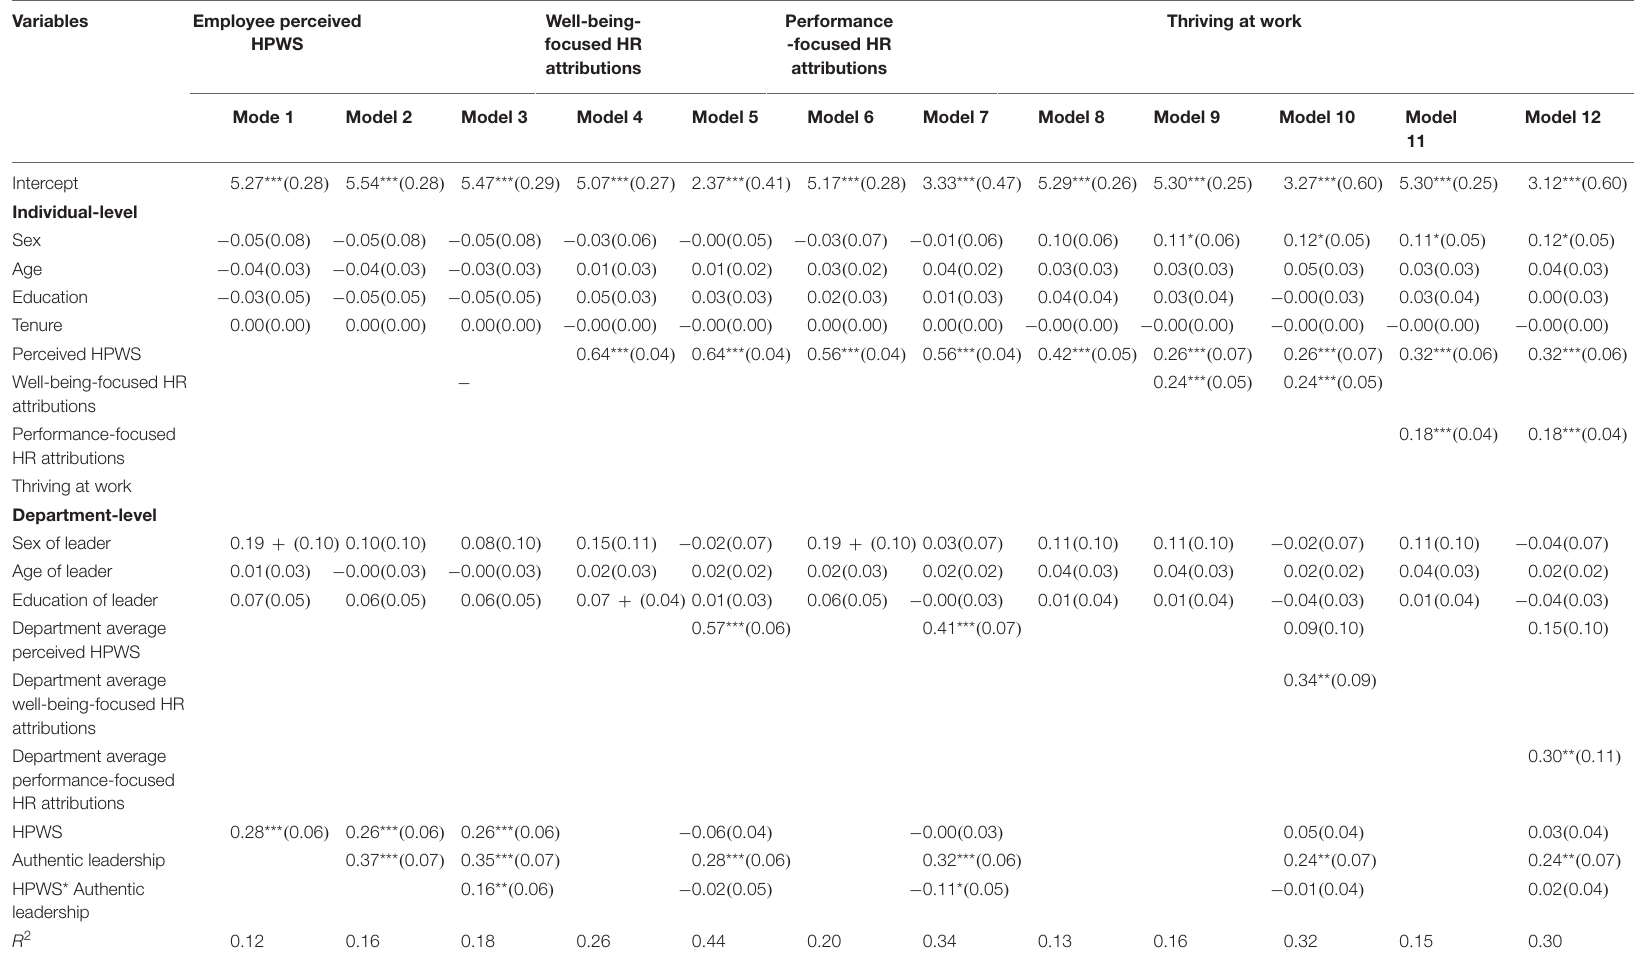
TABLE 3 | Hierarchical linear modeling